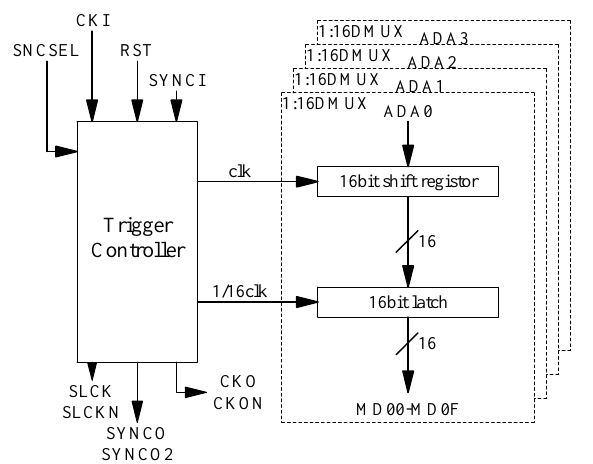
FIG. 4. Block diagram of the FMUX LSI. MD00-MD3F: slow data input (LvTTL); DAA0–ADD3: mulitplexed data output